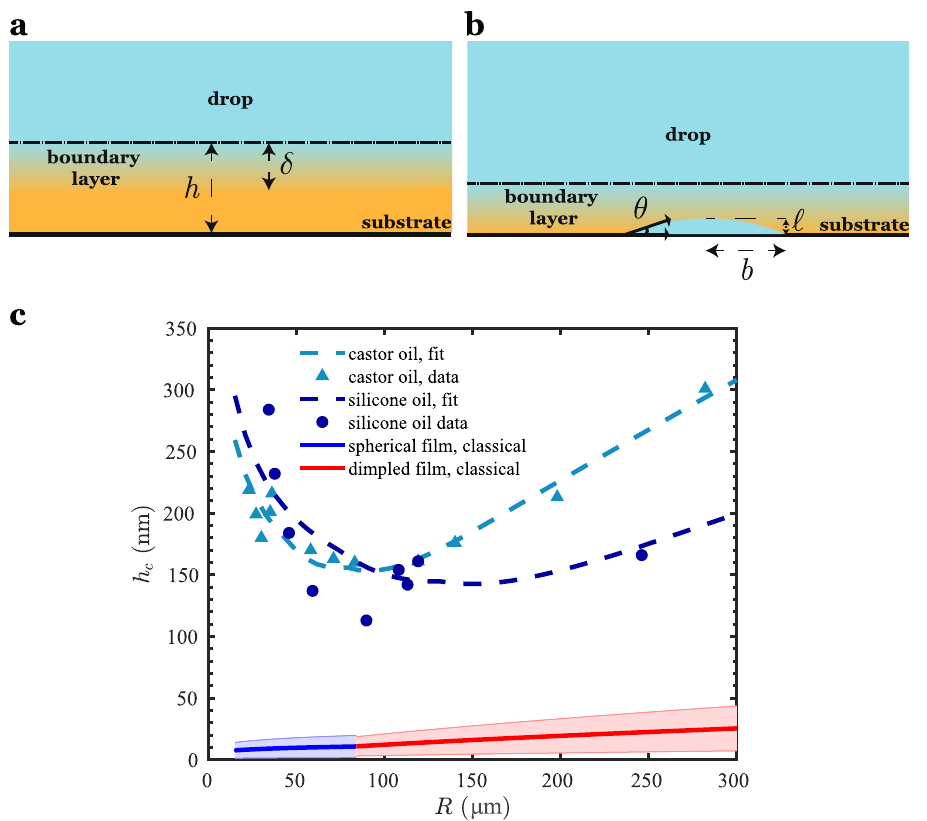
Fig. 5 A concentration boundary layer of dissolved glycerol is present near the drop interface. a As the parent drop settles toward the substrate, a concentration boundary layer of dissolved drop phase formed by a balance between convection and diffusion surrounds the drop-medium interface. The dash-dotted line represents the interface between the drop and the suspending fl uid in the fi lm region. The symbols h and δ are the fi lm and the concentration boundary layer thicknesses, respectively. b When the drop-substrate separation is nearly equal to the boundary layer thickness, the onset of nucleation takes place. The symbols ‘ and b are the island height and radius, respectively, while θ is the contact angle. c The critical height, which is the fi lm height at which the island intercepts the parent drop, as a function of the parent drop radius for glycerol drops of different sizes in castor oil and silicone oil settling toward plasma-treated SU-8. The experimental critical heights are taken to be the minimum fi lm height before the fi lm ruptures (castor oil), or to be the fi lm height prior to its increase due to island growth and delayed bridge formation (silicone oil). The drainage constants (Fig. 2) were c 1 = 1.13, c 2 = 0.13 and c 3 = 0.45, obtained from fi lm drainage data. The fi tted values for SO1000-G-PS are k = 8.3 µ m 3 h − 1 and θ = 33.8°, which agree well with independent measurements of 7.4 – 136 µ m 3 h − 1 and 32 – 55°, respectively (Fig. 4). For the castor oil/glycerol/plasma-treated SU-8 system, the constants k = 3.6 µ m 3 h − 1 , θ = 37.4°, c 1 = 1, c 2 = 0.1 and c 3 = 0.4 were fi tted. The interfacial tension ( σ ) used in the calculations for the two systems were measured separately to be 30 and 10 mN m − 1 , respectively. The critical heights based on attractive van der Waals forces ( A H = 10 − 20 – 10 − 19 J) corresponding to spherical (blue curve) and dimpled (red curve) fi lms were plotted taking σ = 20 mN m − 1 and − 20 and 10 − 19 Δ ρ = 300kgm − 3 . The thicknesses of the shaded regions around the blue and red curves show the effect of varying A H between 10